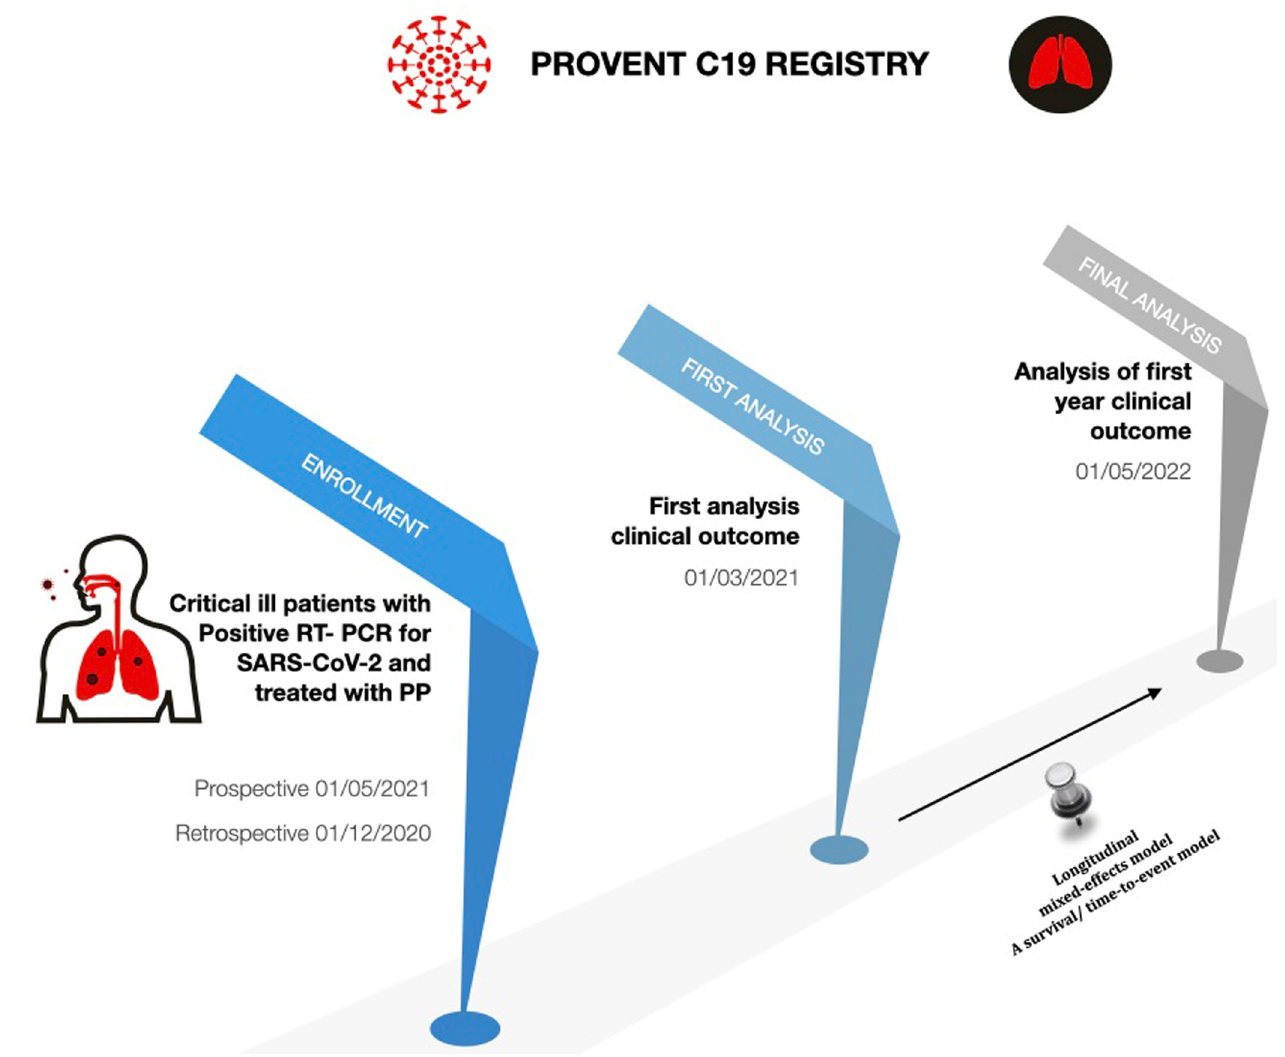
Fig 1. Timeline of the